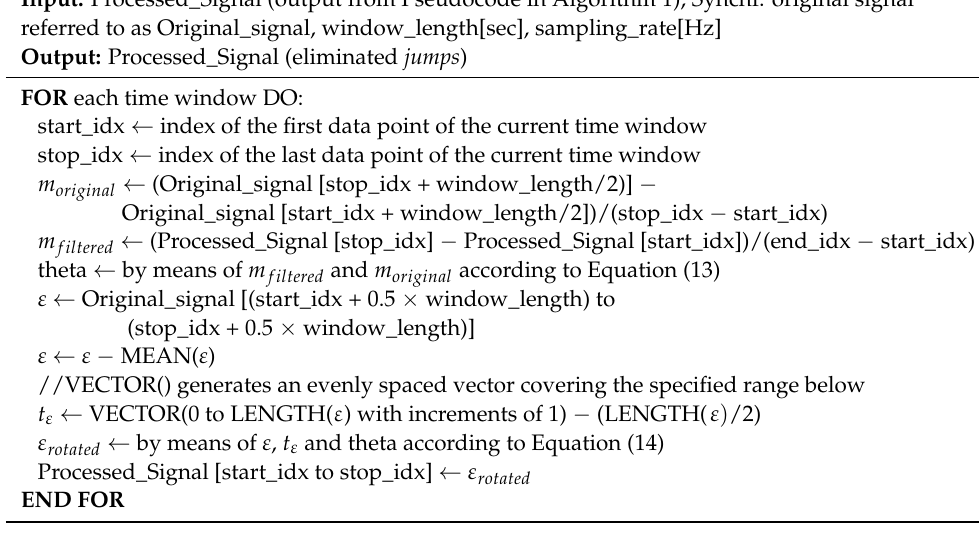
Algorithm 2 For the mitigation of the signal discontinuities resulting from the pseudocode in Algorithm 1